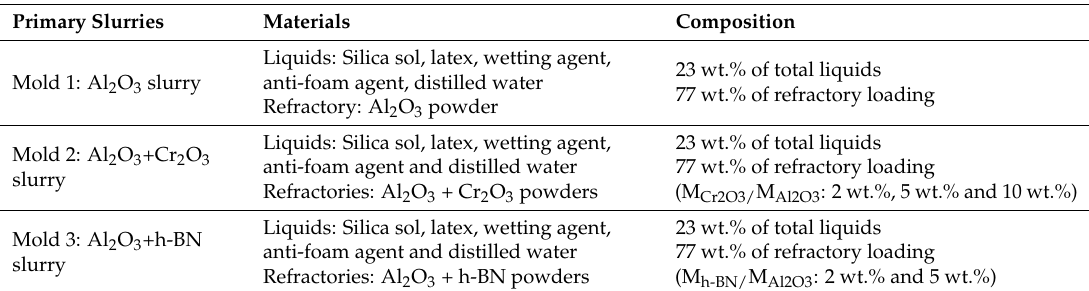
Table 1. Primary slurry composition for ceramic molds.